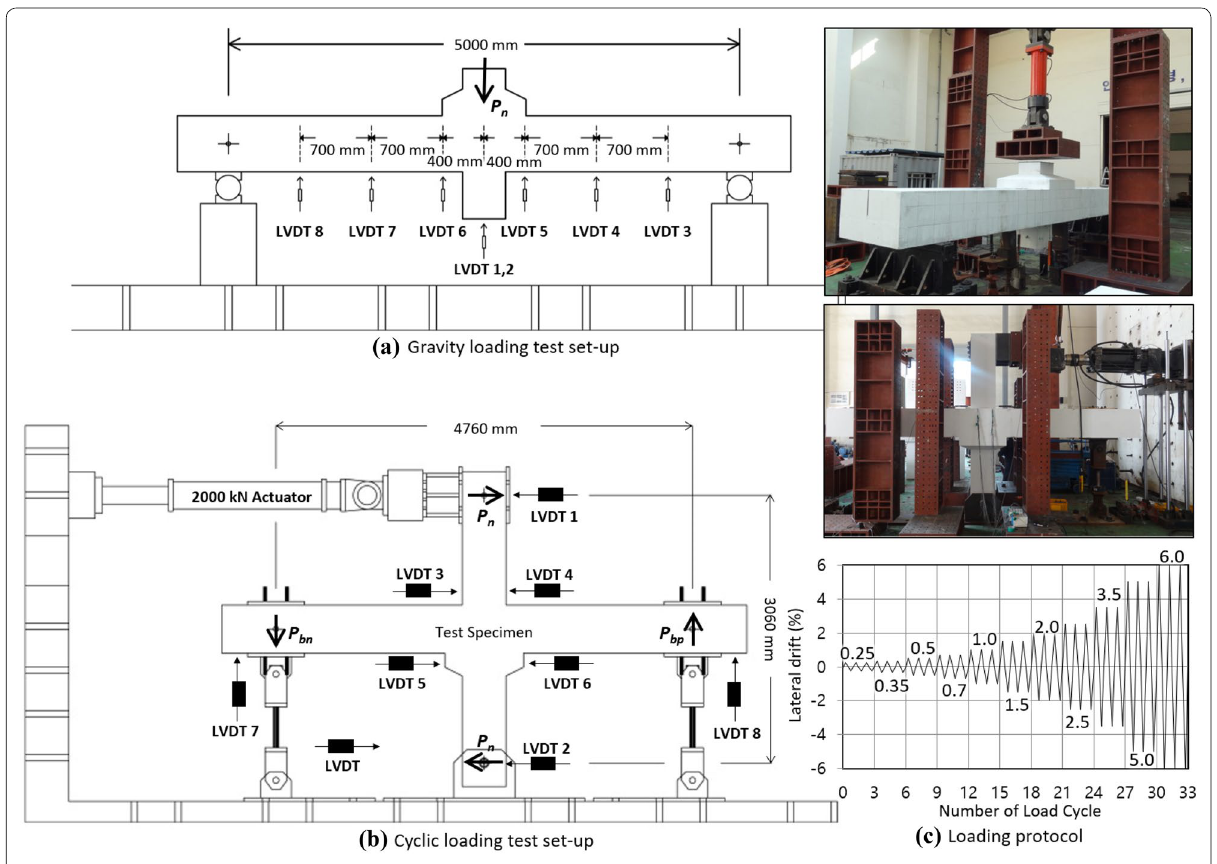
Fig. 9 Test setup and loading